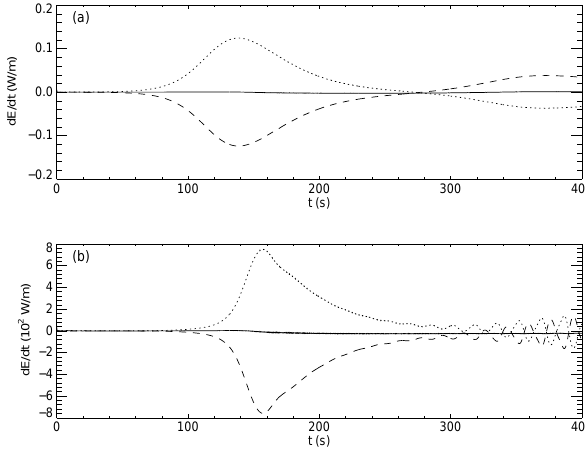
Fig. 9. Energy balance for an ISW shoaling through a turning point. (a) Dots: d( ¯ E kp + ¯ E a )/dt . Dashed: 1p s M . Solid: their sum. (b) Dots: d( ¯ E k2 + ¯ E a )/dt . Dashed: R R D u 0 w d Note different scales used in each